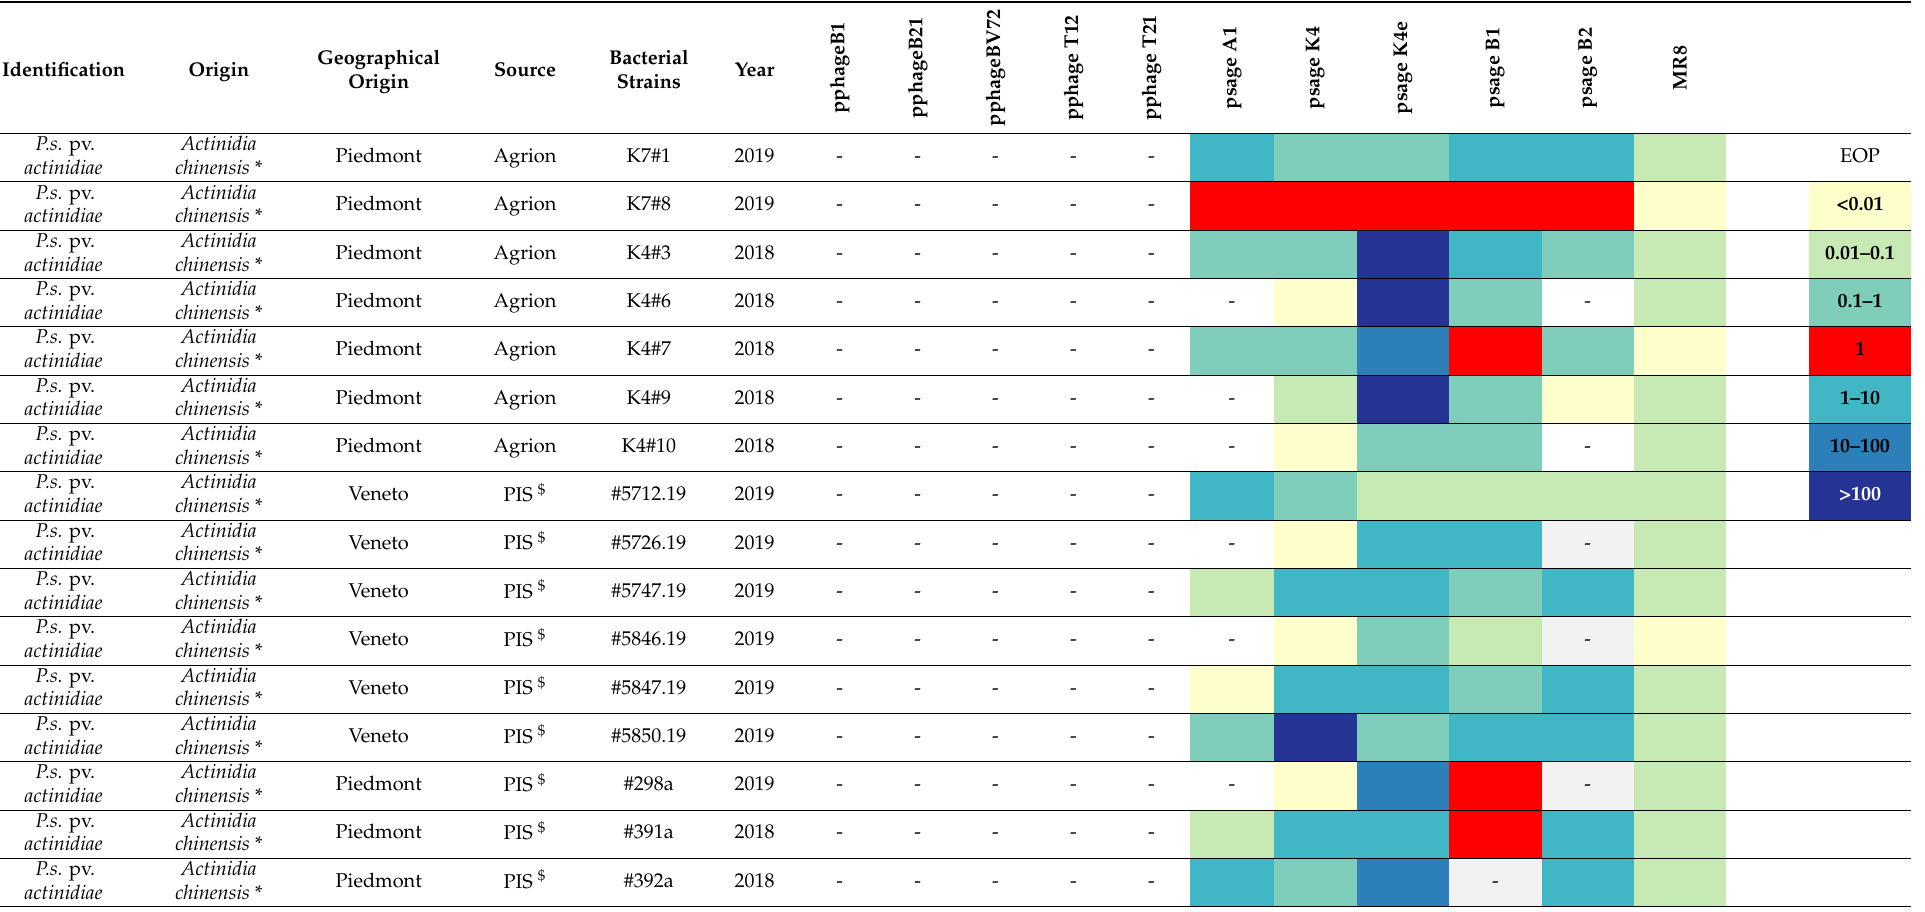
Table 1. Pseudomonas syringae pv. actinidiae and pv. phaseolicola strains properties and their phage sensitivity profiles. The key to phage efficiency of plating (EOP) is shown at the right end of the table. Red color indicates an EOP comparable to the one measured in the isolation strain (K7#8 for psageA1, psageK4, psageK4e, psageB1 and psage B2; Pph Cuneo #6_18 for pphageB1, pphageB21, pphageBV72, pphageT12 and pphageT21; Pph Cuneo #6_18 is arbitrarily chosen as reference for MR8). The other colors represent different levels of EOP with darker colors indicating a greater efficiency in their lytic activity. “-“ symbols represent cases for which plaques have not been observed at any concentration of the crude lysate. * Variety deliciosa ; $ Phytosanitary Inspection